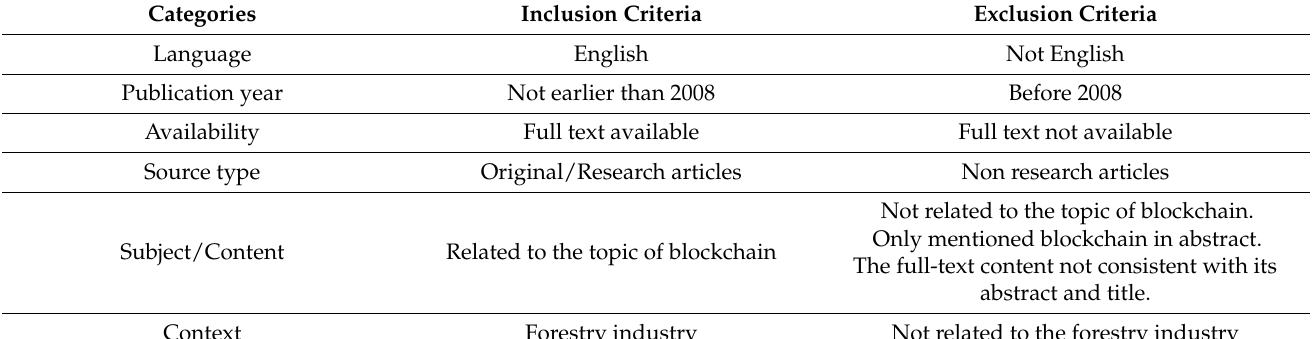
Table 1. Inclusion and exclusion criteria to select papers in this